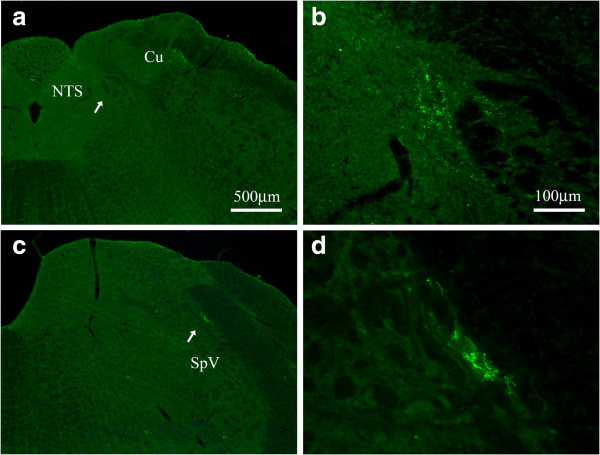
CTB-labeled transganglionic axonal terminals at the NTS and the SpV. Coronal sections through the medulla oblongata showing the CTB-labeled transganglionic axonal terminals at NTS (a, b) and SpV (c, d). Higher magnified photos (b, d) from a and c (arrow head) showing the labeled terminals in detail respectively. Same scale bar for a and c, and for b and d. Cu, cuneate nucleus; NTS, nucleus tractus solitarius; SpV, spinal trigeminal nucleus.